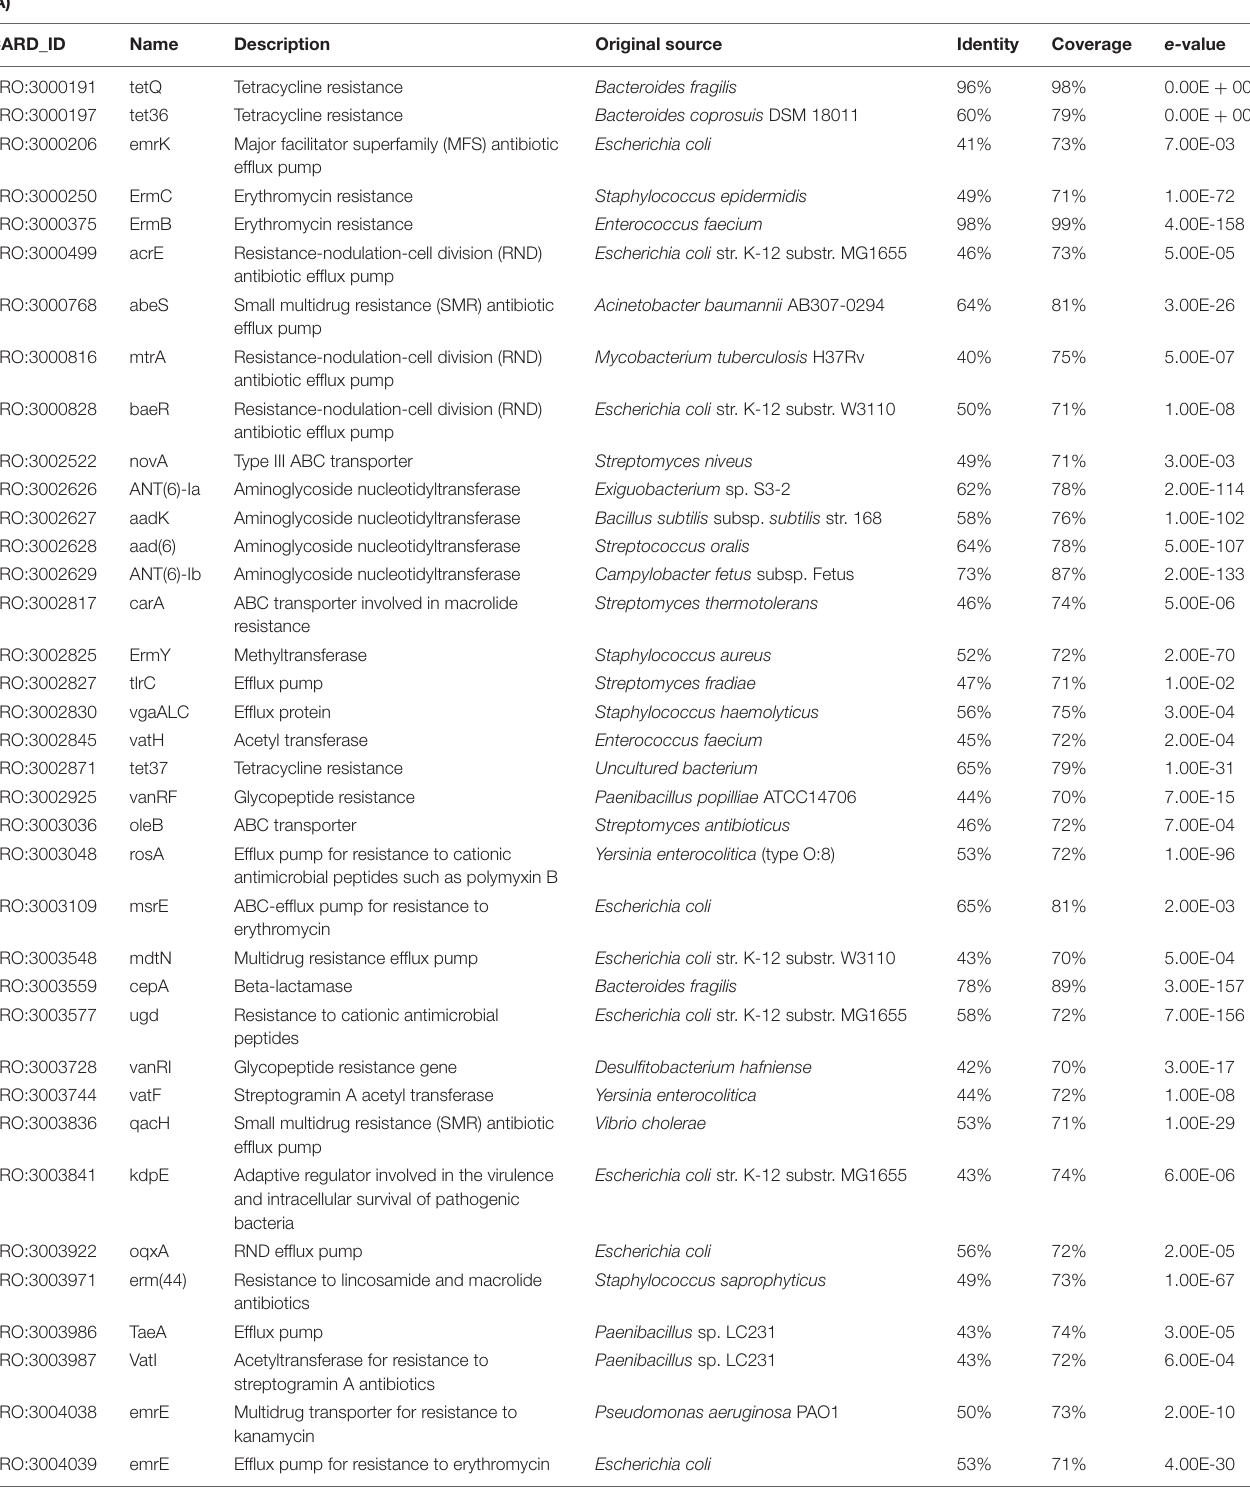
TABLE 2 | (A) Predicted genes associated with antibiotic resistance in the genome of B. ovatus ELH-B2; (B) minimum inhibitory concentrations for antibiotics against B. ovatus ELH-B2 and B. ovatus JCM5824 ( µ g/ml).